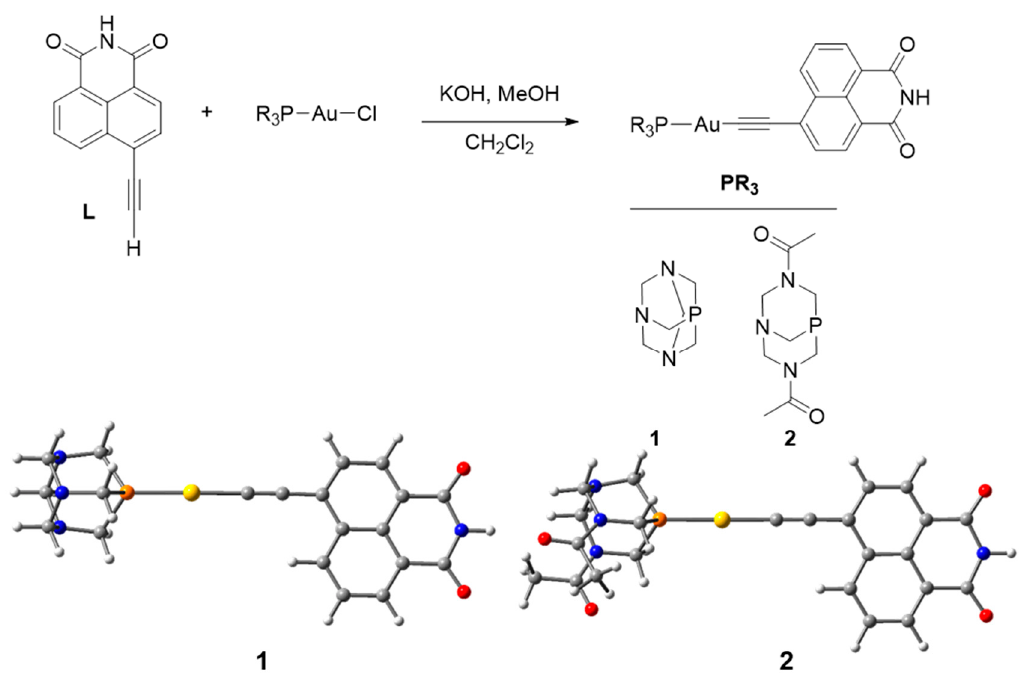
Table 1. Absorption and emission ( λ exc = 418 nm) spectral data of L , 1 and 2 in DMSO.